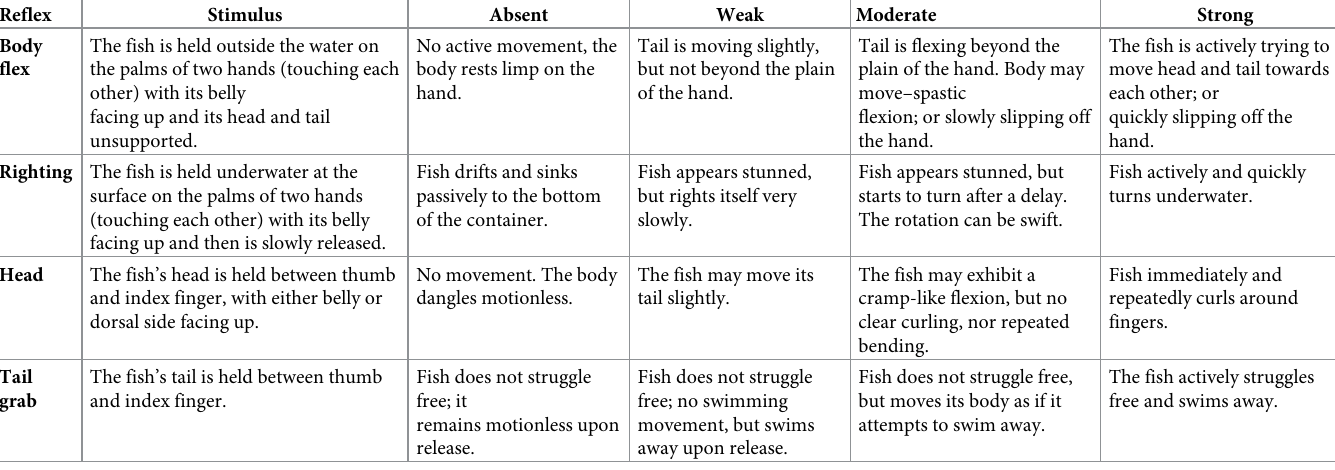
Table 1. List of scoring criteria for categorical reflex responses (i.e., absent, weak, moderate, and strong) of common sole ( Solea solea ) in the order tested within 5 s of observation after stimulus (based on [4, 9]). Reflex Stimulus Absent Weak Moderate Strong Body The fish is held outside the water on flex the palms of two hands (touching each other) with its belly facing up and its head and tail unsupported. Righting The fish is held underwater at the surface on the palms of two hands (touching each other) with its belly facing up and then is slowly released. Head The fish’s head is held between thumb and index finger, with either belly or dorsal side facing up. Tail The fish’s tail is held between thumb grab and index finger.